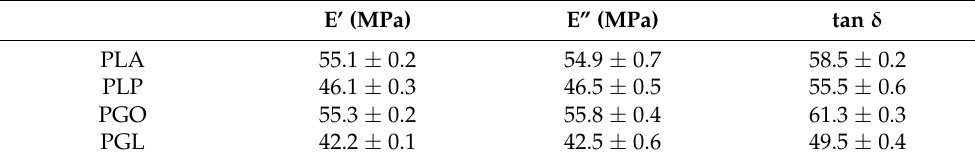
Figure 6. Dynamic mechanical analysis of the effect of temperature on storage ( a ) and loss ( b ) moduli. Table 10. T g in ◦ C, calculated from the representations of E’, E”, and tan δ